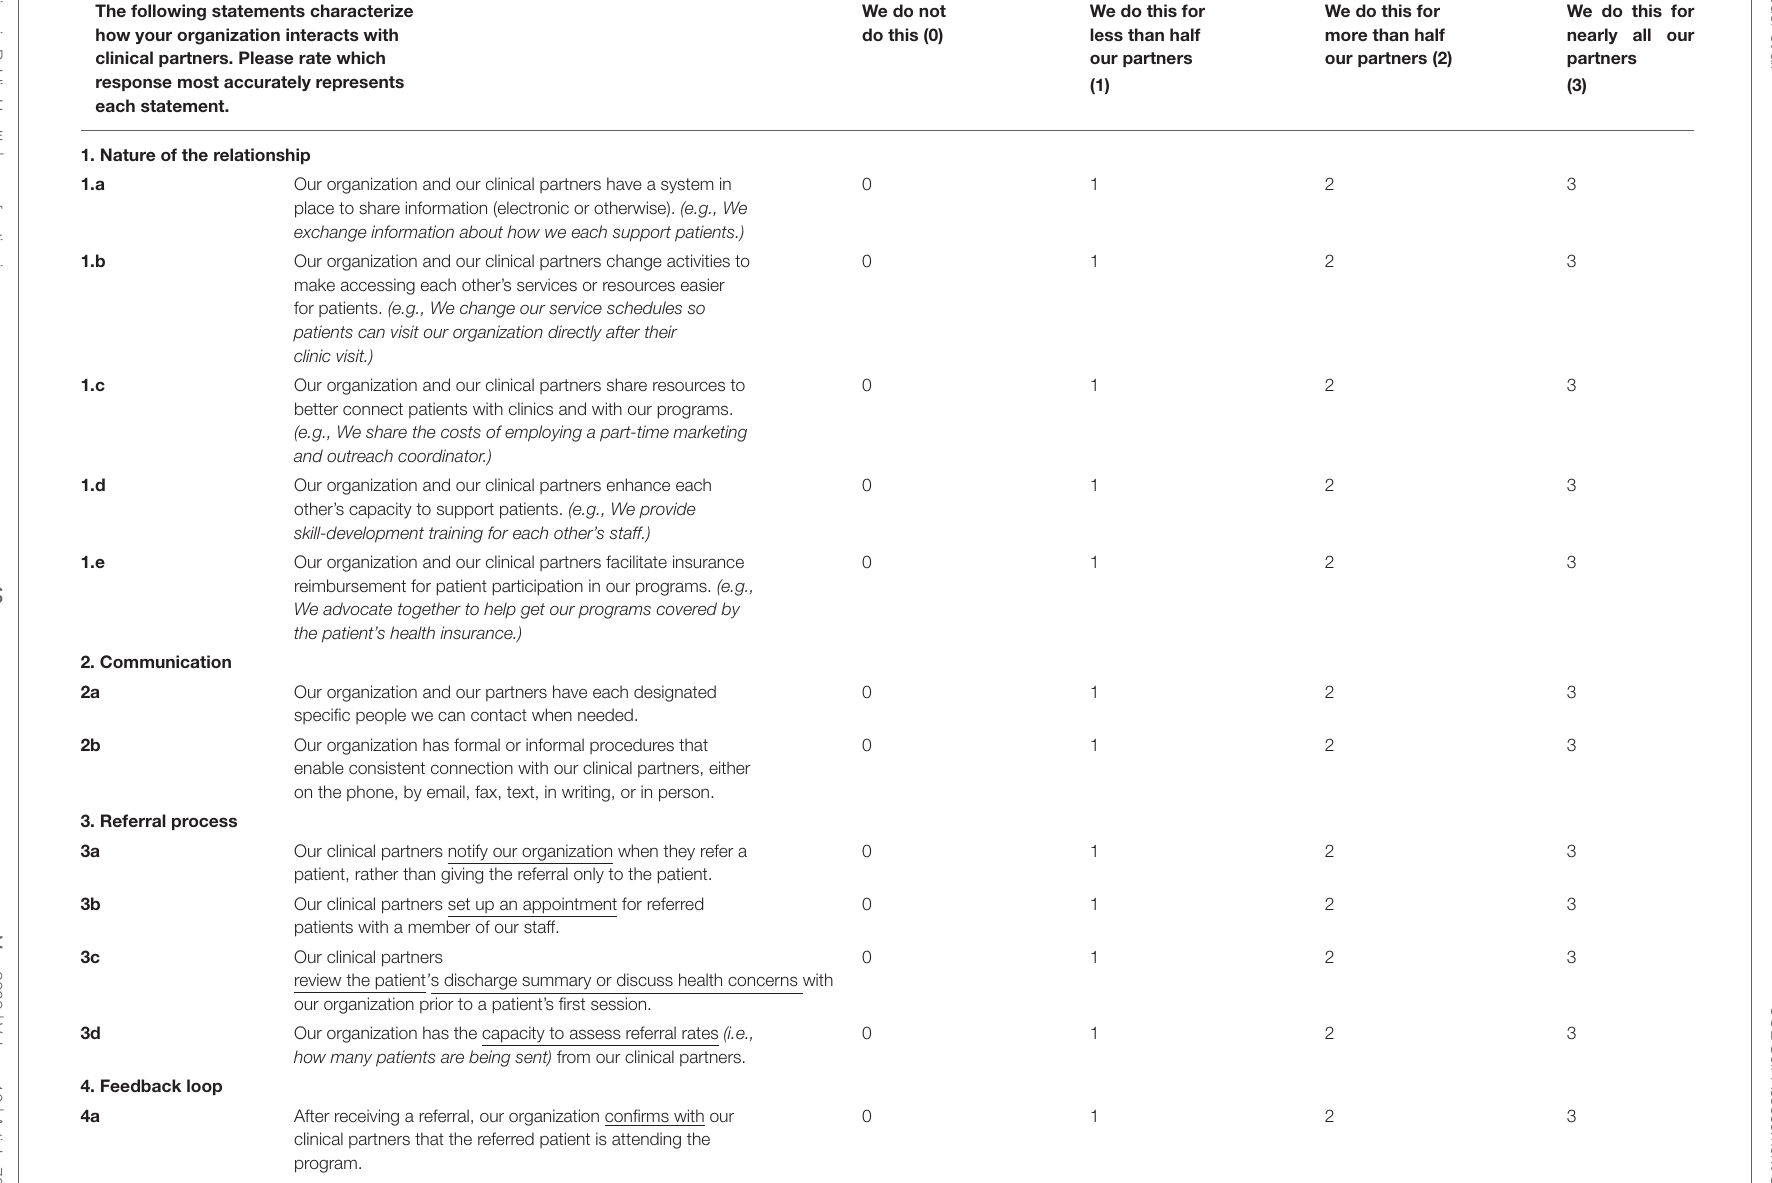
TABLE 2 | Complete clinical-community linkage self-assessment survey. The following statements characterize how your organization interacts